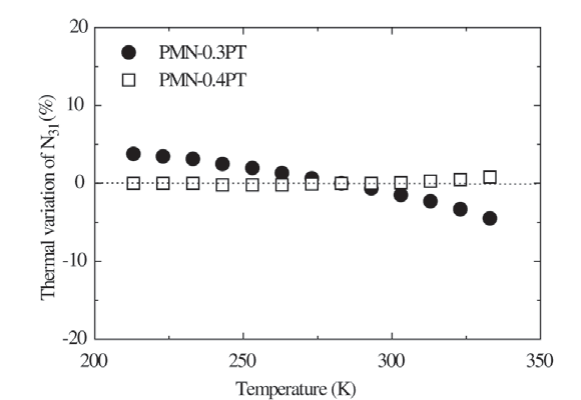
Figure 2. Thermal variation of the frequency constant (N PMN-0.3PT and PMN-0.4PT ceramics.